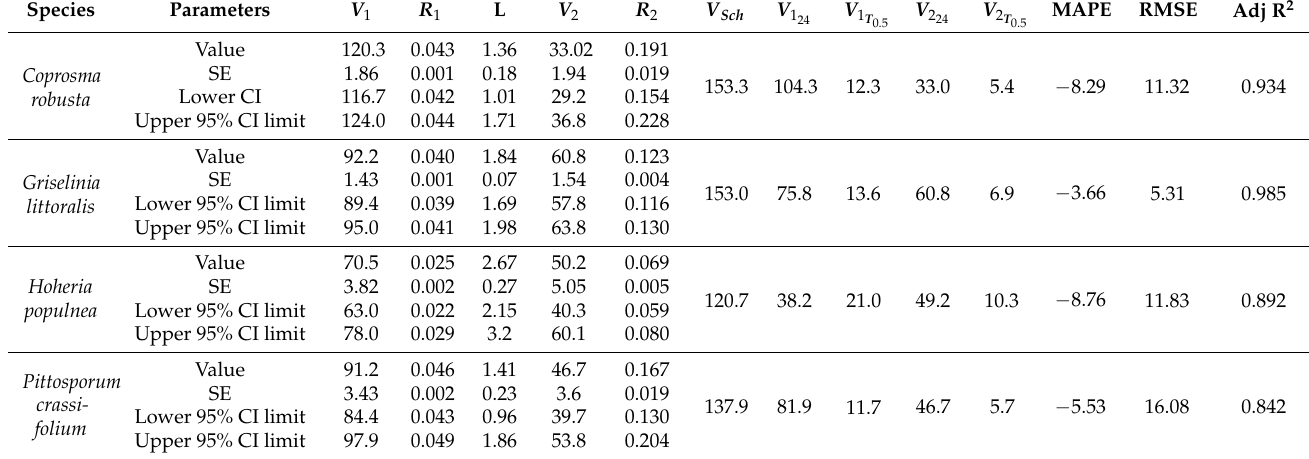
Table 7. Native ( Coprosma robusta, Griselinia littoralis, Hoheria populnea , and Pittosporum crassifolium ) and exotic ( Salix schwerinii ) shrub species leaf in vitro fermentation kinetic parameters derived using dual-pool model, where: L, lag time (h); V 1 , fast-pool total gas production (mL/g DM); V 2 , slow pool (mL/g DM); R 1 , fast-pool rate of gas production (%/h); R 2 , slow rate (%/h); V Sch , total gas production (mL/g DM); V 1 , total gas production for the fast pool after 24 h (mL/g DM); V 2 24 pool after 24 h (mL/g DM); V 1 , fast-pool total-gas-production half-life (h); and V 2 T 0.5 half-life